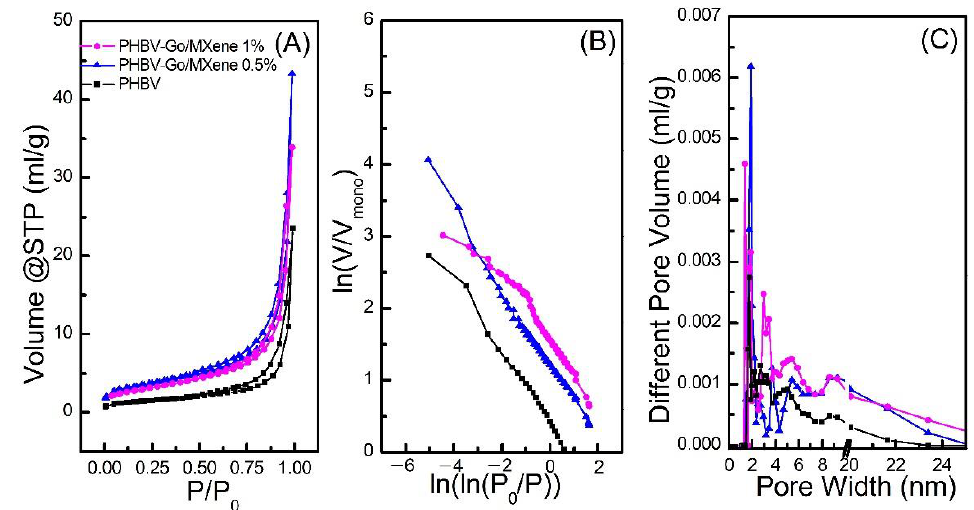
Figure 4. Plots of N2 adsorption—desorption ( A ), ln (V/Vmono) vs. ln (P/P o ) ( B ) and pore diameter ( C ) distributions of PHBV, PHBV—GO/MXene 0.5%, and PHBV—GO/MXene 1% composite